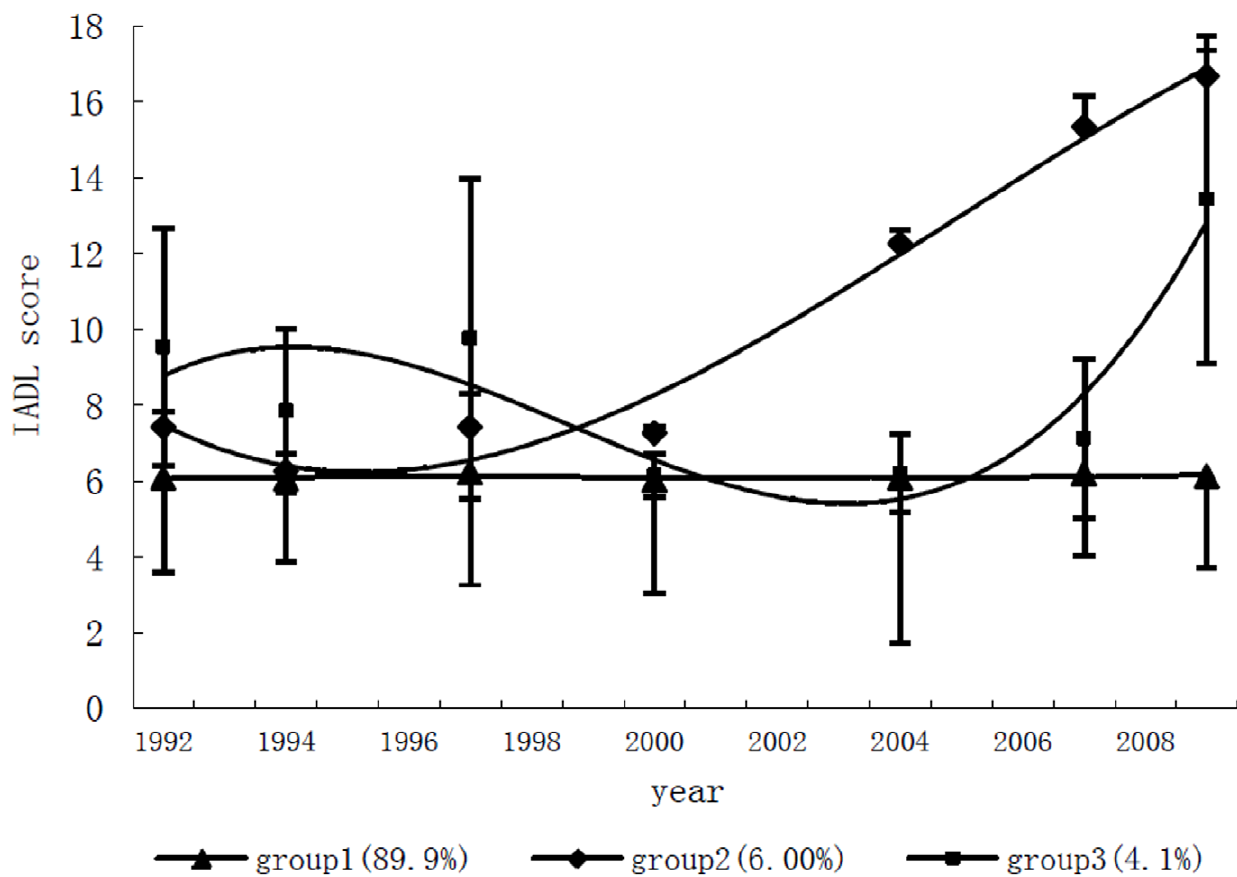
Figure 1. Trajectories of IADL score over time. Bar represented the SD for IADL score in each group in every visit.